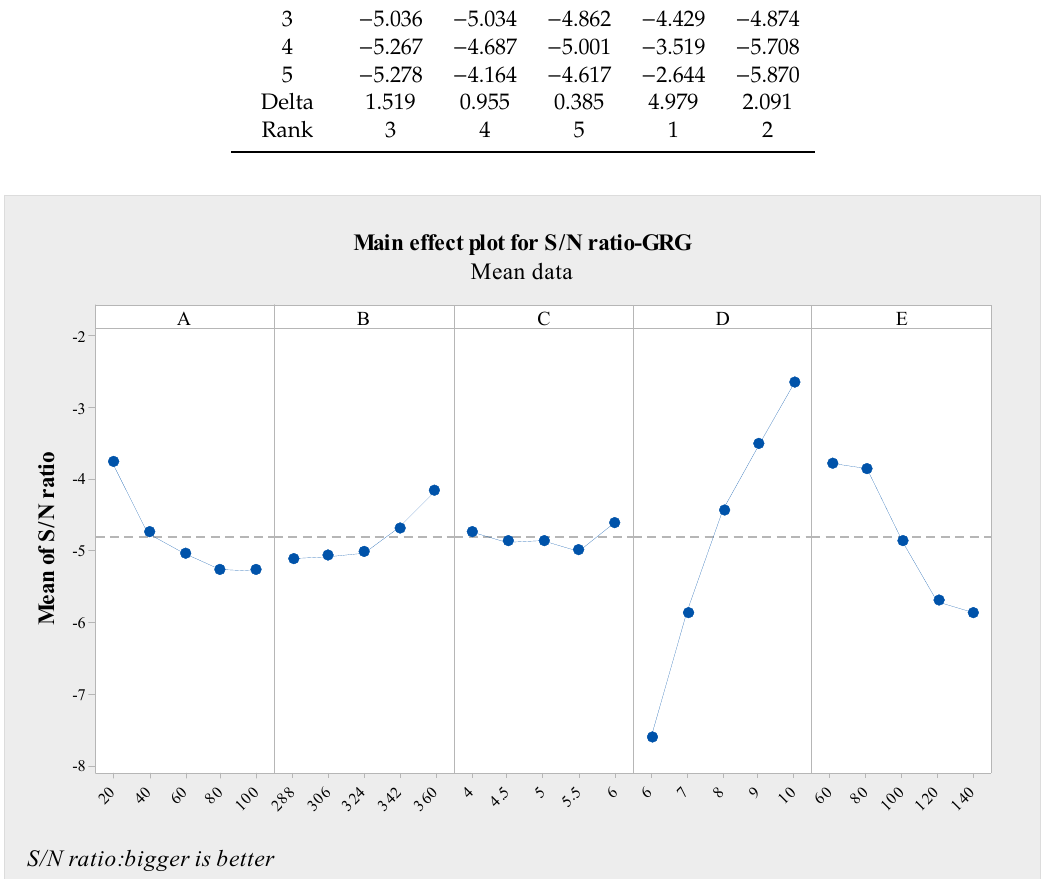
Figure 18. The e ff ect of each factor on the performance of the two Figure 18. The effect of each factor on the performance of the two responses. Table 14. ANOVA table for the grey relational grade.